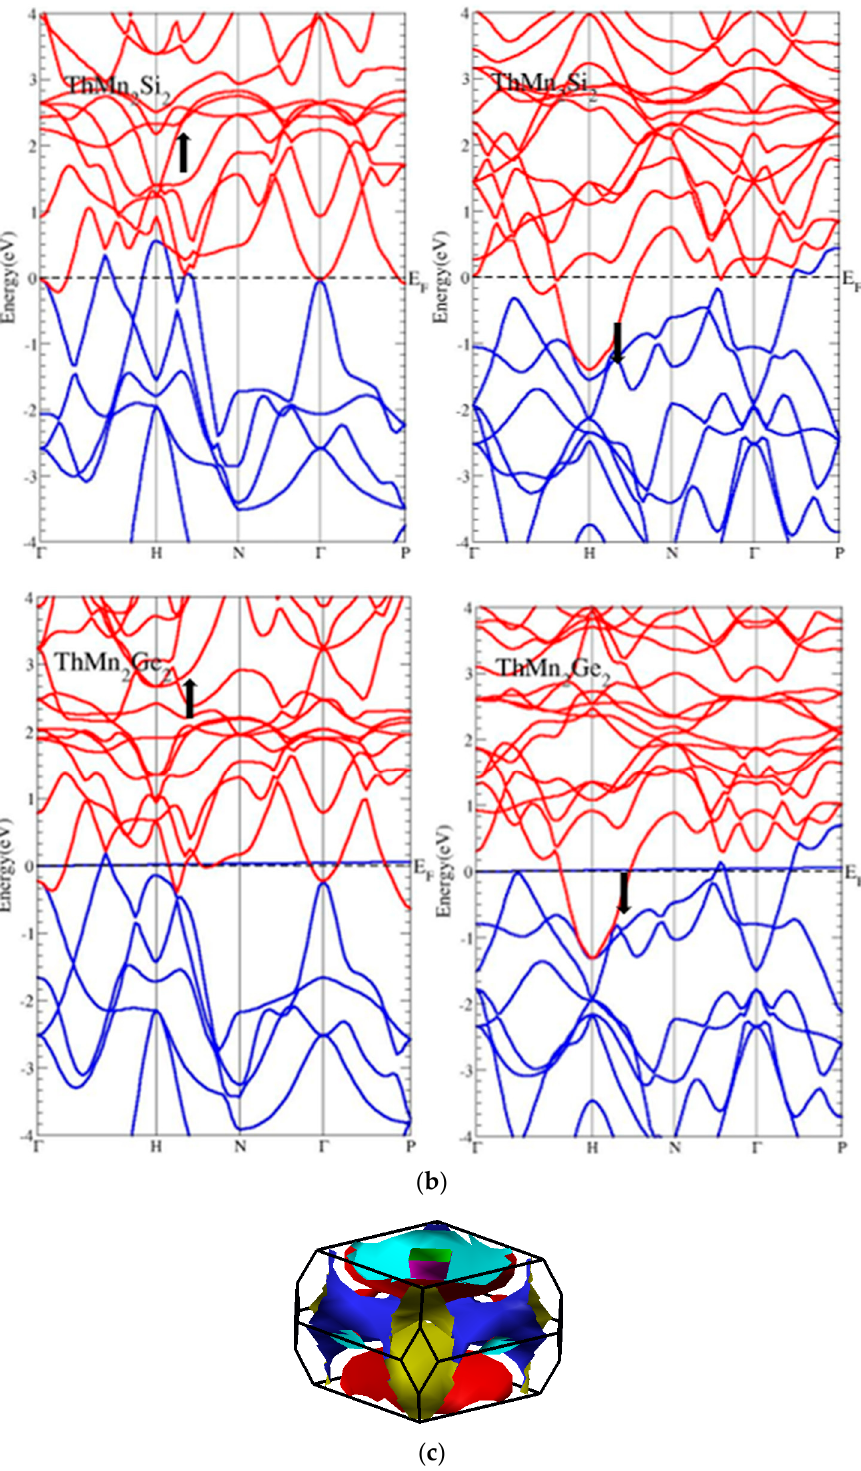
Figure 4. ( a ) Band structures of the ThMn 2 Si 2 and ThMn 2 Ge 2 compounds in body-centered tetragonal ferromagnetic phase while using GGA–PBE in both spin states; ( b ) band structures of the ThMn 2 Si 2 and ThMn 2 Ge 2 compounds in body-centered tetragonal ferromagnetic phase while using GGA + U in both spin states; ( c ) Fermi surface sheet of ThMn 2 Ge 2 as a prototype of ThMn 2 X 2 , in the body-centered tetragonal Brillouin zone boundaries. The character of Fermi surfaces are primarily constituted by the Th f , Mn d , and X p states.